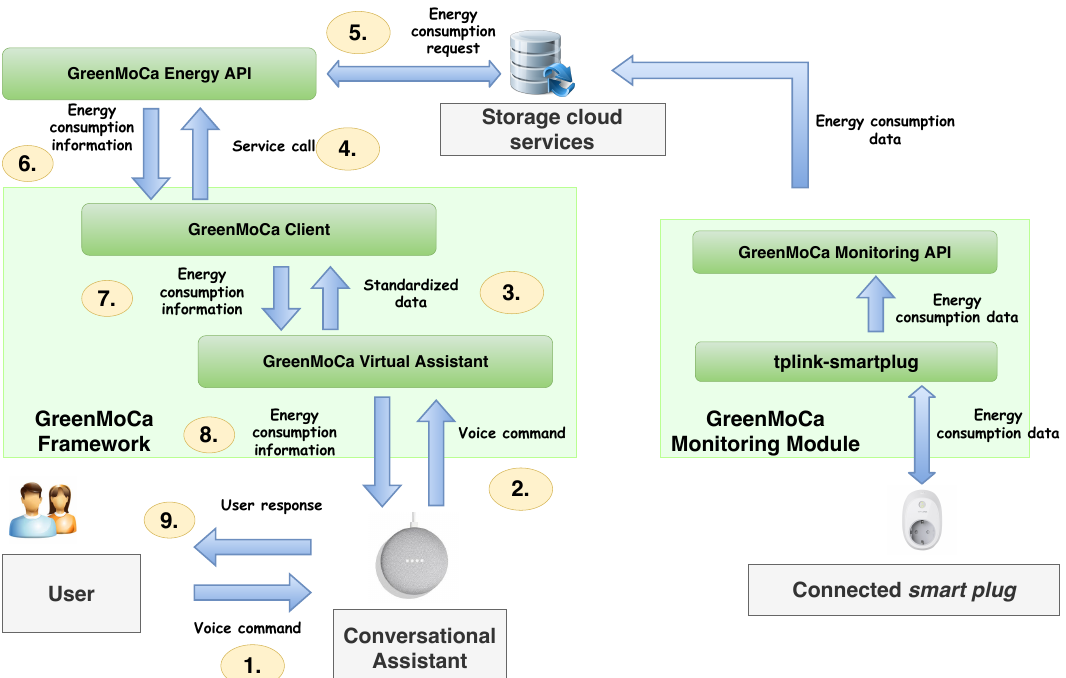
Figure 1. General overview of GreenMoCA system, taking into account the main elements and flows between